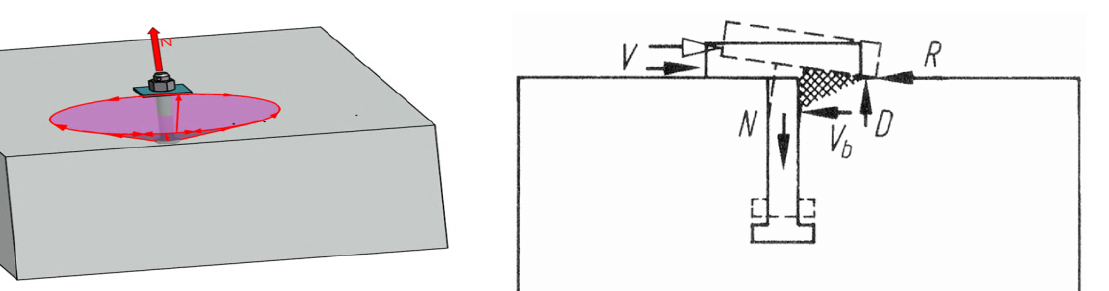
Figure 7. Supporting mechanism of a head bolt anchorage due to shear load (Eligehausen, Mallée & Silva 2006)